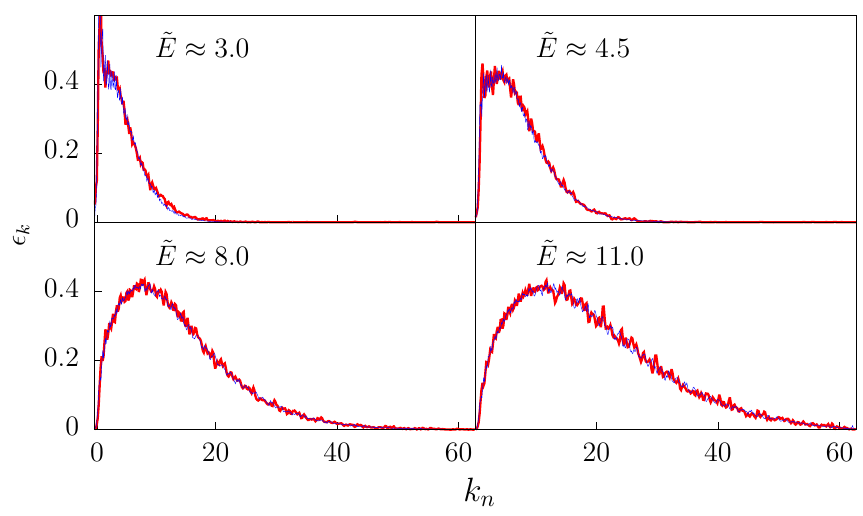
Figure 8 . The distribution of energy over the modes (cid:15) k per wave number for the upper boundary solutions for N r = 400 ; R = 20 (red, thick line) and N r = 600 ; R = 30 (blue, thin line) (cid:12)gures 2 and